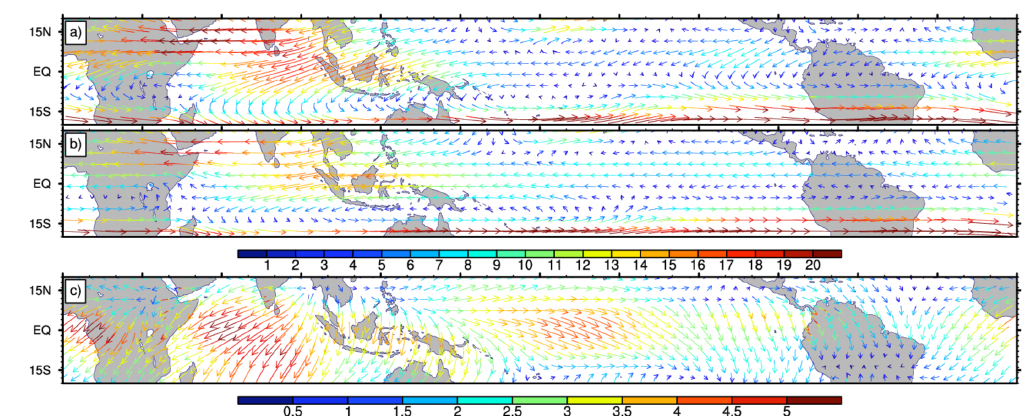
Figure 13. As in Fig. 12 but for the model level 51 (about 909hPa).